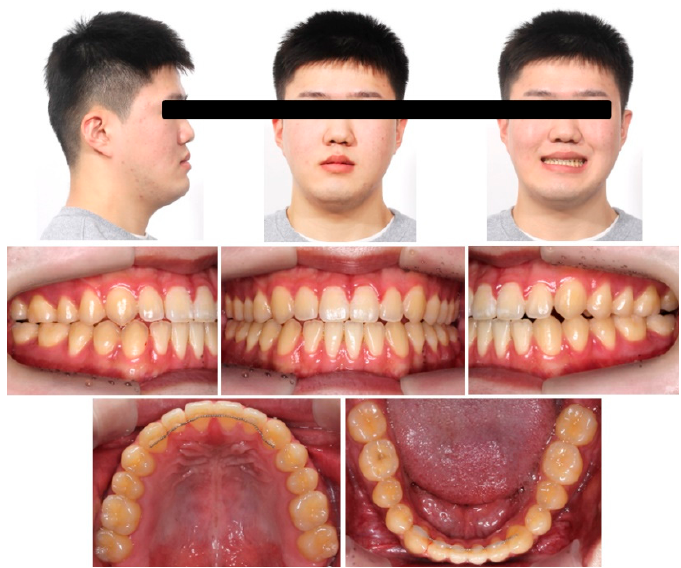
Figure 14. 22-month retention facial and intraoral photographs.